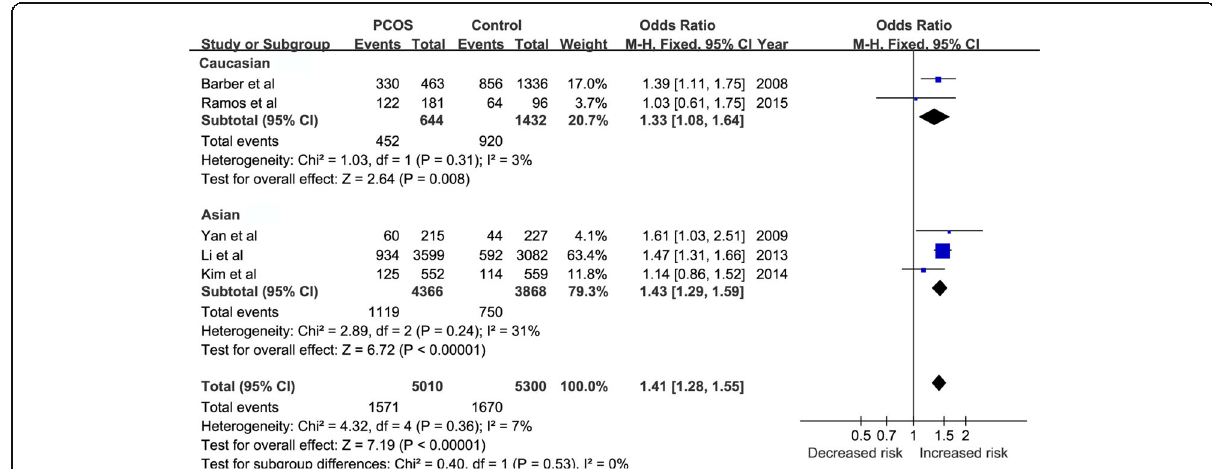
Fig. 3 The association between FTO rs9939609 A/T polymorphism and risk of PCOS in subgroup model. The analysis was stratified by race. AA + AT vs. TT in subgroup (Caucasian and Asian) analysis of HWE > 0.05. The solid squares represent the ORs from the individual studies, horizontal lines represent corresponding 95% CIs. The pooled ORs and 95% CIs are presented as diamonds